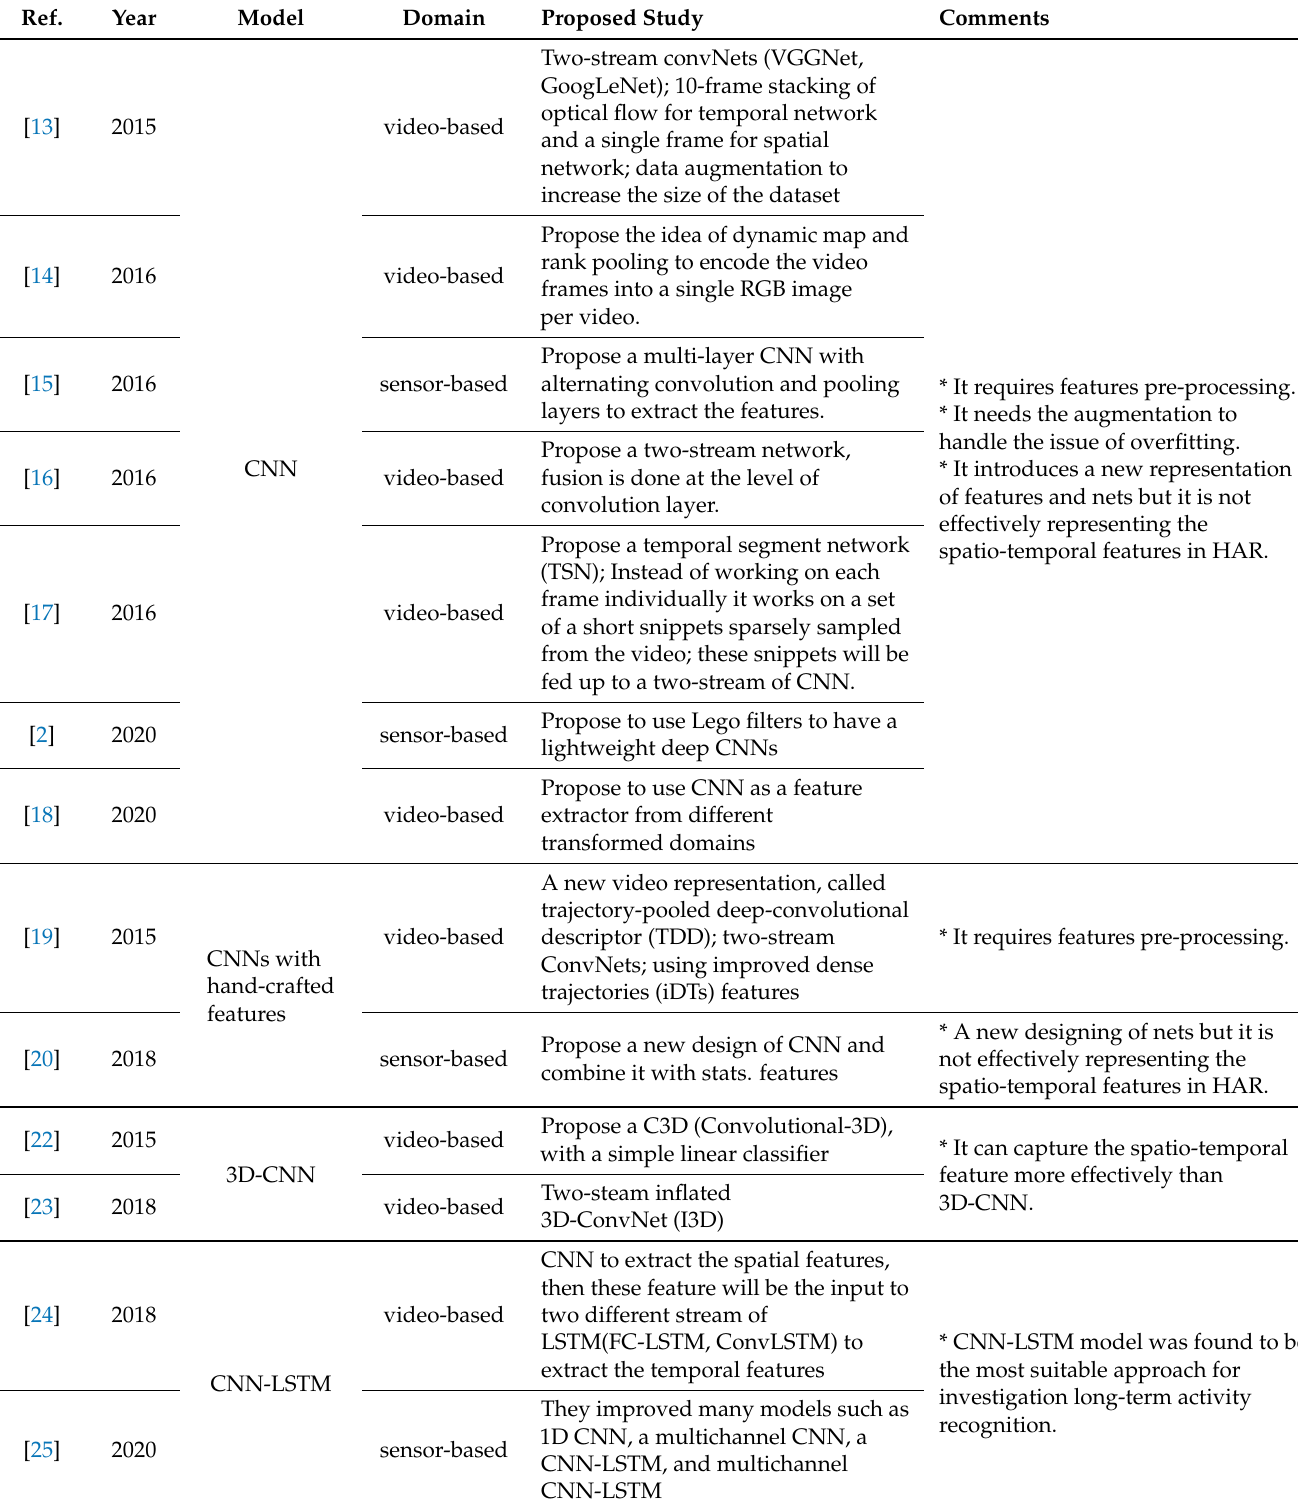
Table 1. Summary of the proposed studies in the related work.